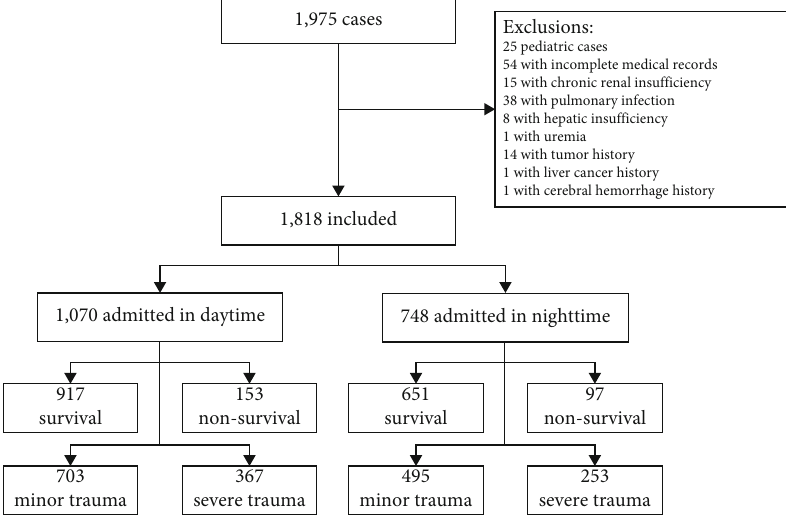
Figure 1: Composition of included